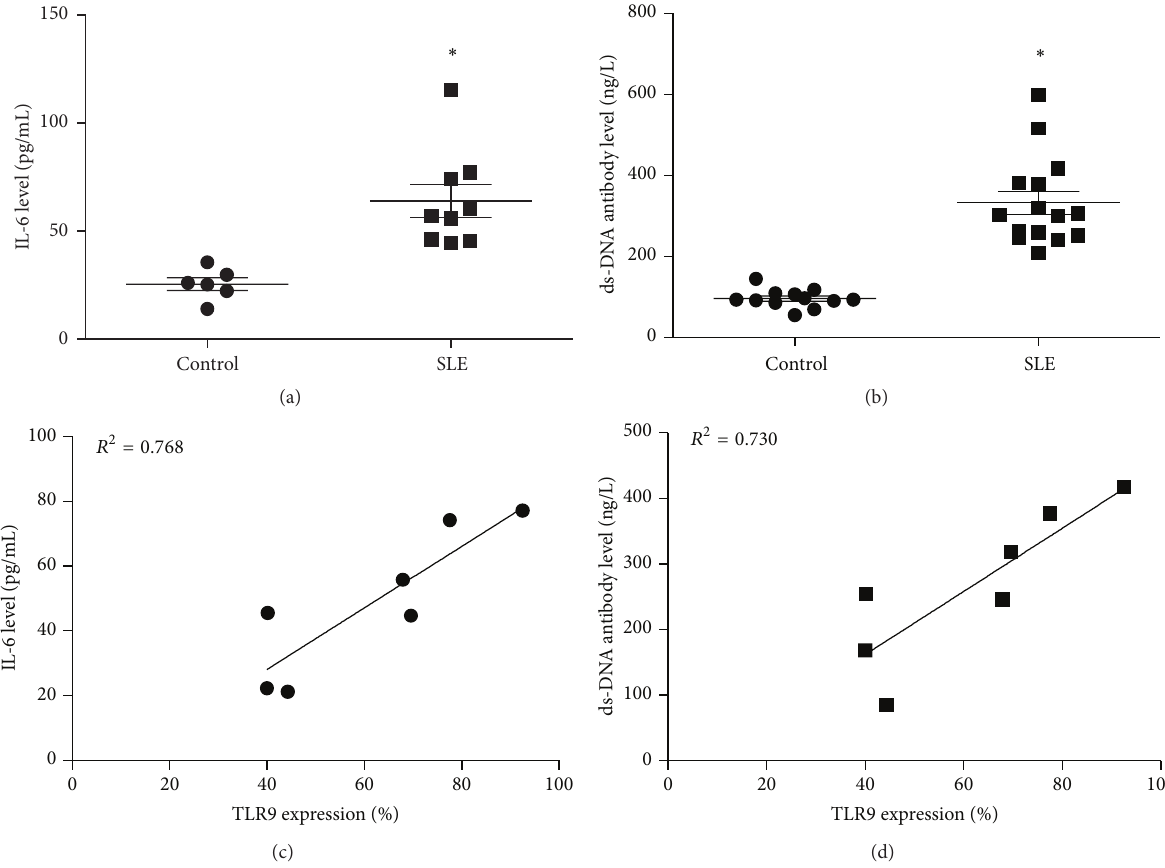
Figure 2: Correlation analyses between TLR9 expression and cytokines level in SLE patients. (a)-(b) IL-6 and ds-DNA antibody level in SLE patients; (c)-(d) correlation between TLR9 overexpression and IL-6 or ds-DNA antibody level. ∗ 𝑃 < 0.05 , compared with the